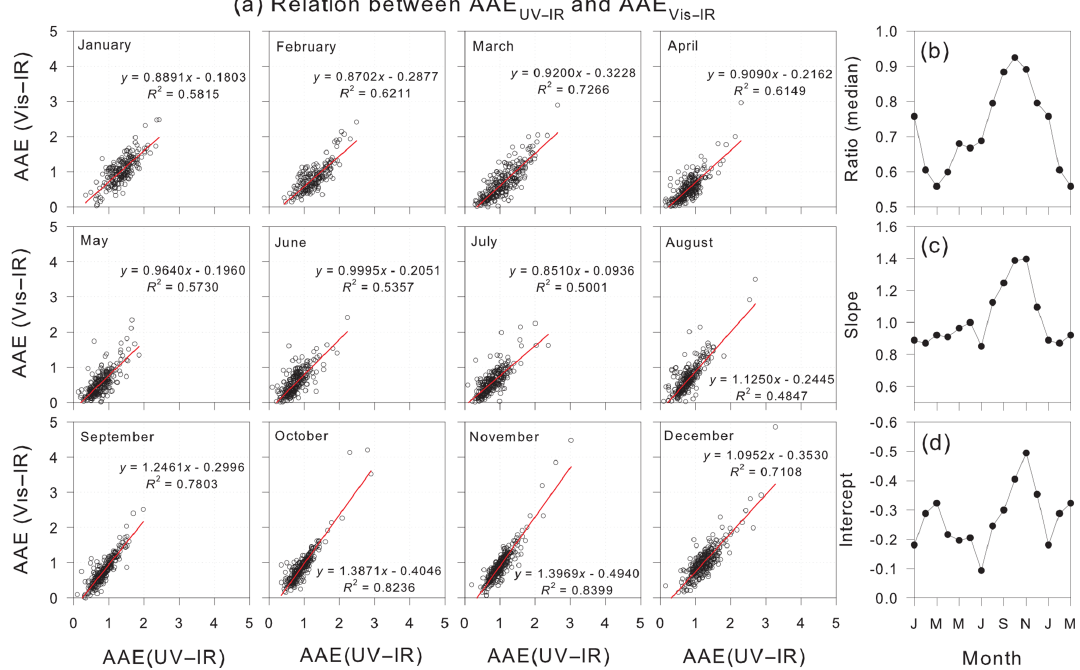
Figure 11. (a) Relations between absorption Angstrom exponent (AAE) in UV–IR channels and AAE in Vis–IR channels, and seasonal fea- tures of (b) ratios of AAE Vis − IR / AAE UV / IR and (c) slope and (d) intercepts in the linear regression lines. AAE data with BC concentrations lower than 0.2ngm − 3 (detection limit) were excluded from the plots. Red lines represent regression lines.